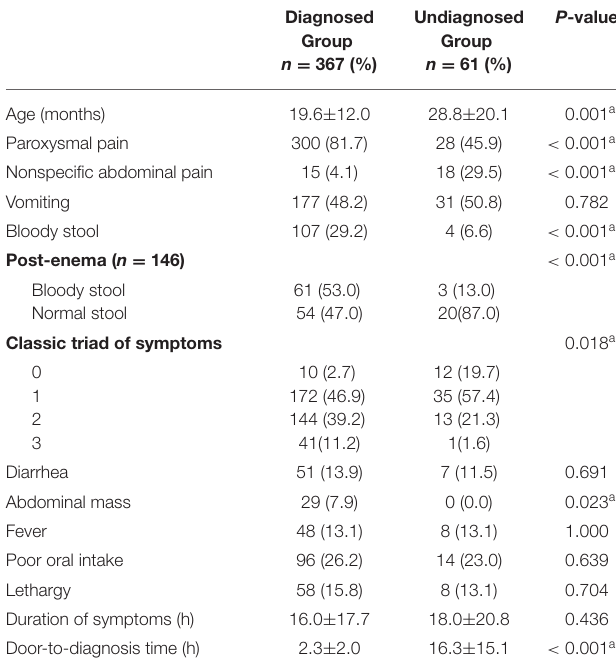
TABLE 3 | Clinical findings of enrolled patients in the diagnosed and undiagnosed groups.